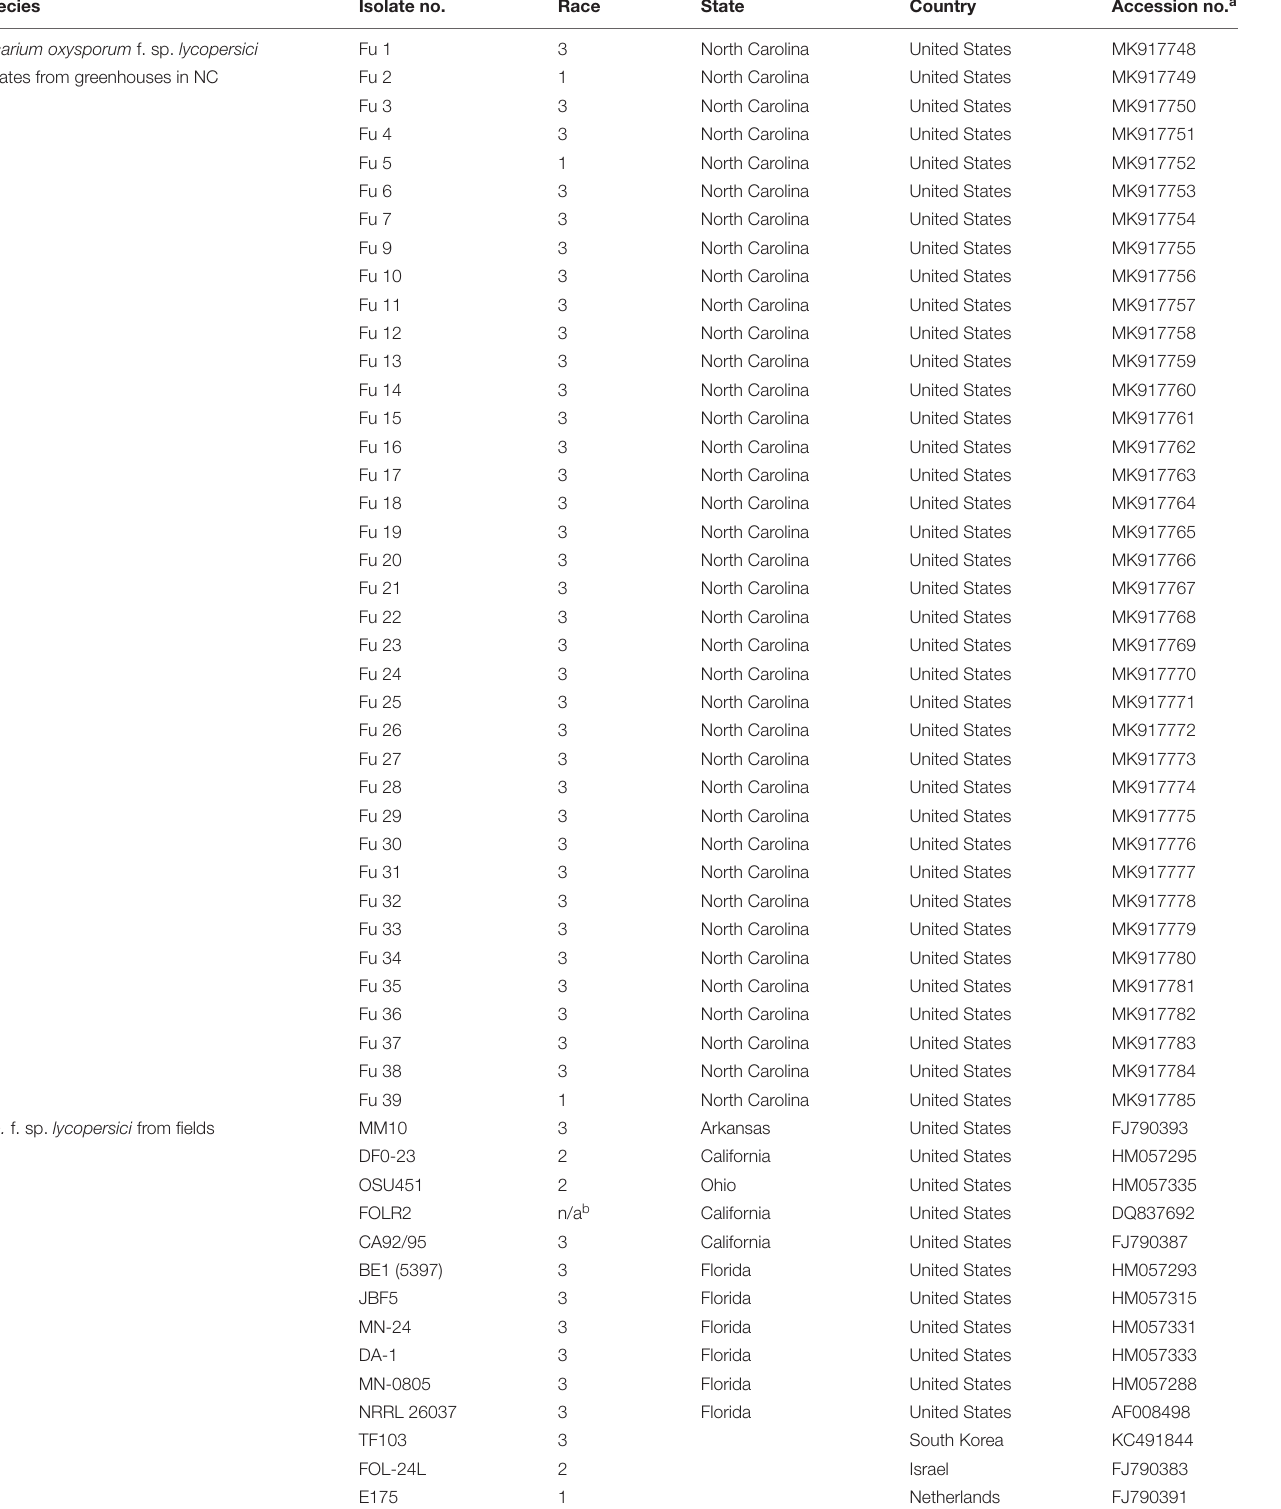
TABLE 2 | The geographic location of origins, accession numbers, and isolates of F. o. f. sp. lycopersici (FOL) sampled from greenhouse tomato production systems in North Carolina (NC) and FOL field and other Fusarium spp. isolates in GenBank. Species Isolate